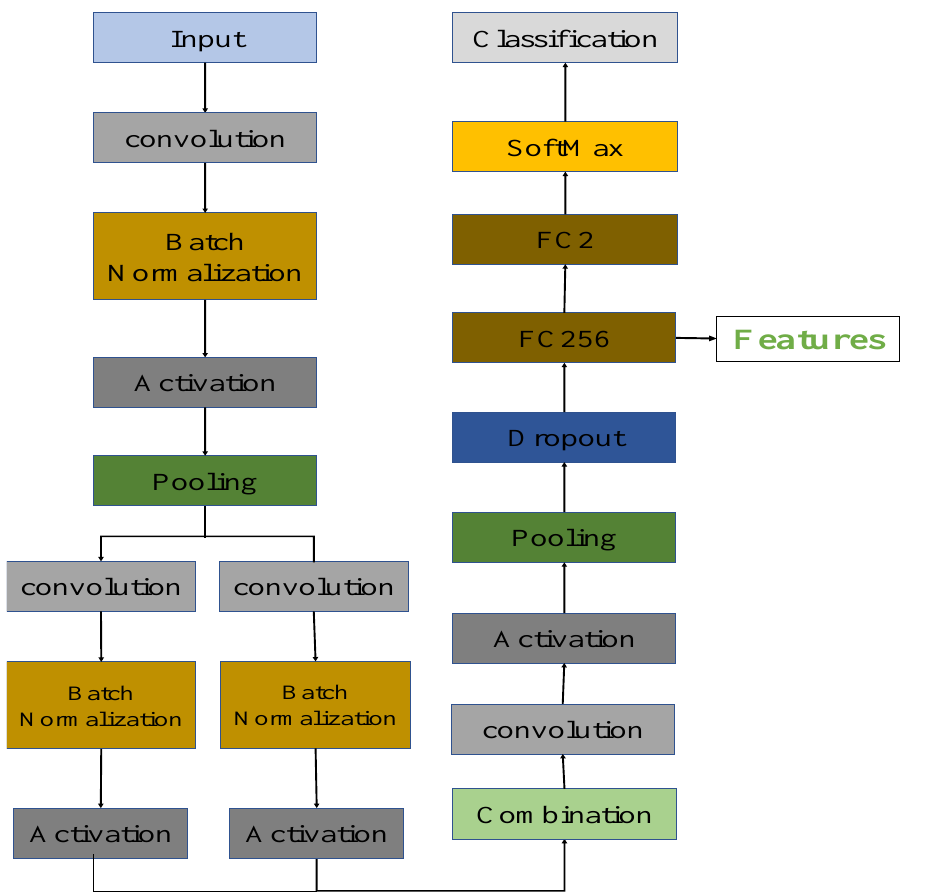
Figure 4. The architecture of the transferred CNNs. FC256 and FC2 are the fully connected layers with 256 and 2 channels,